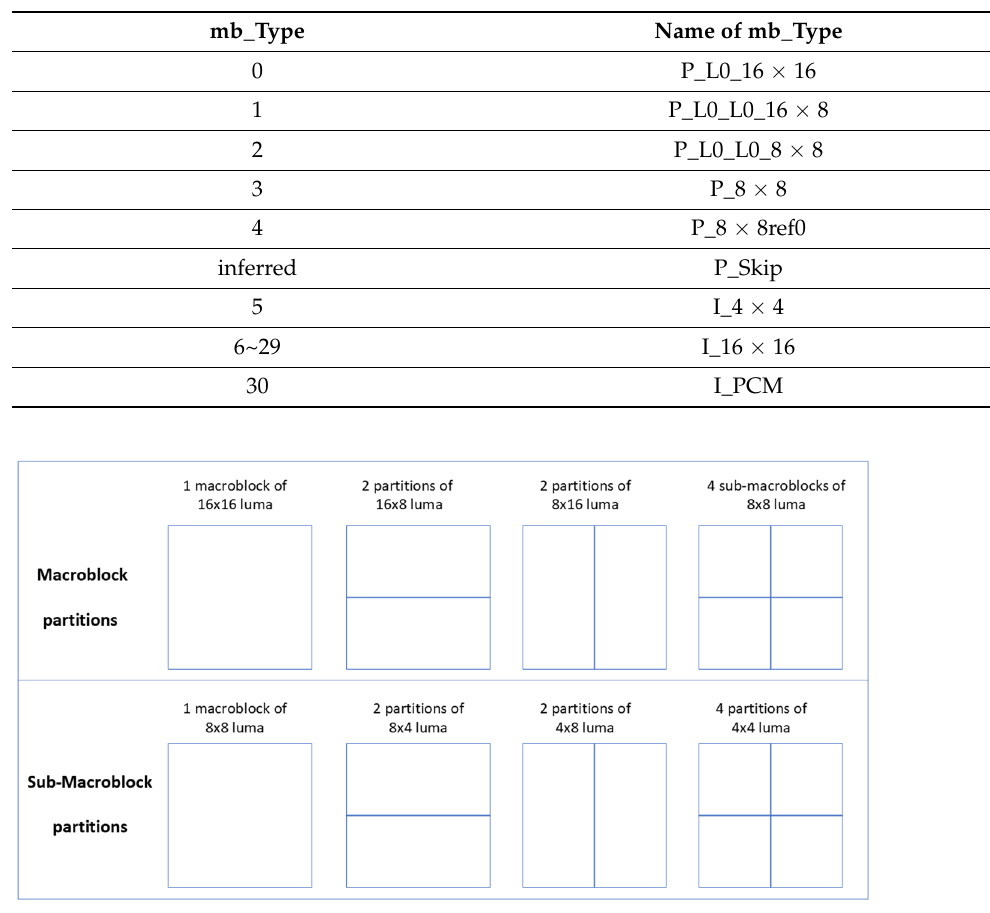
Figure 3. Macroblock partitions in H.264.